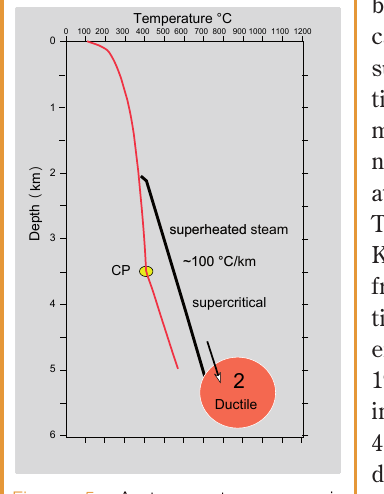
Figure 5. A temperature scenario for a drill hole penetrating a contact aureole along the vertical margin of a cooling intrusion, involving upward flow of superheated steam derived from supercritical fluid.